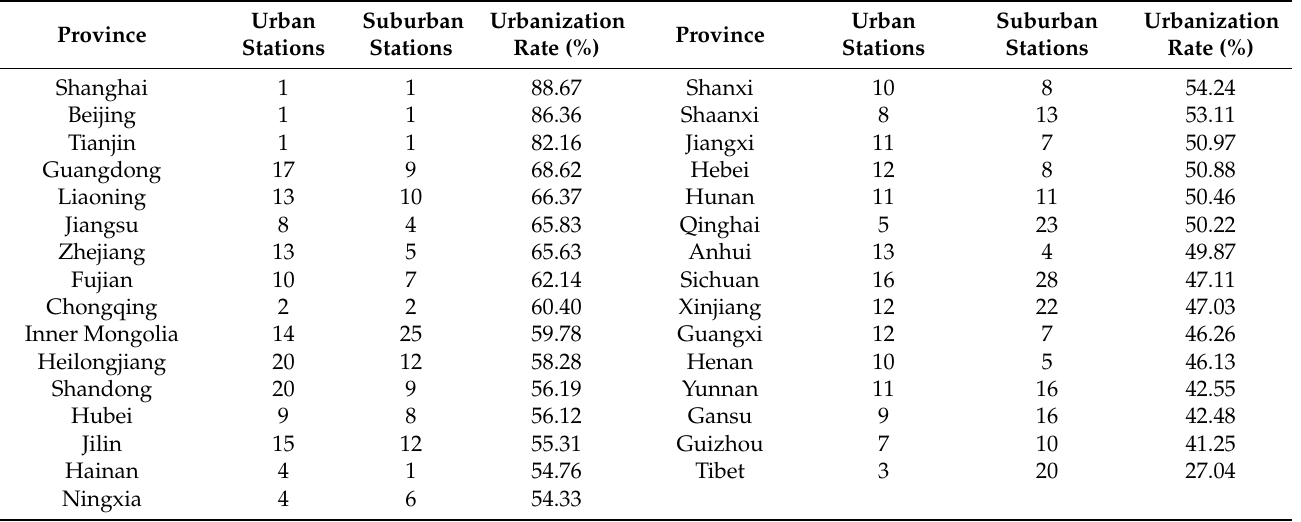
Table 1. Number of urban and suburban stations in each provincial administrative region ranked according to the urbanization